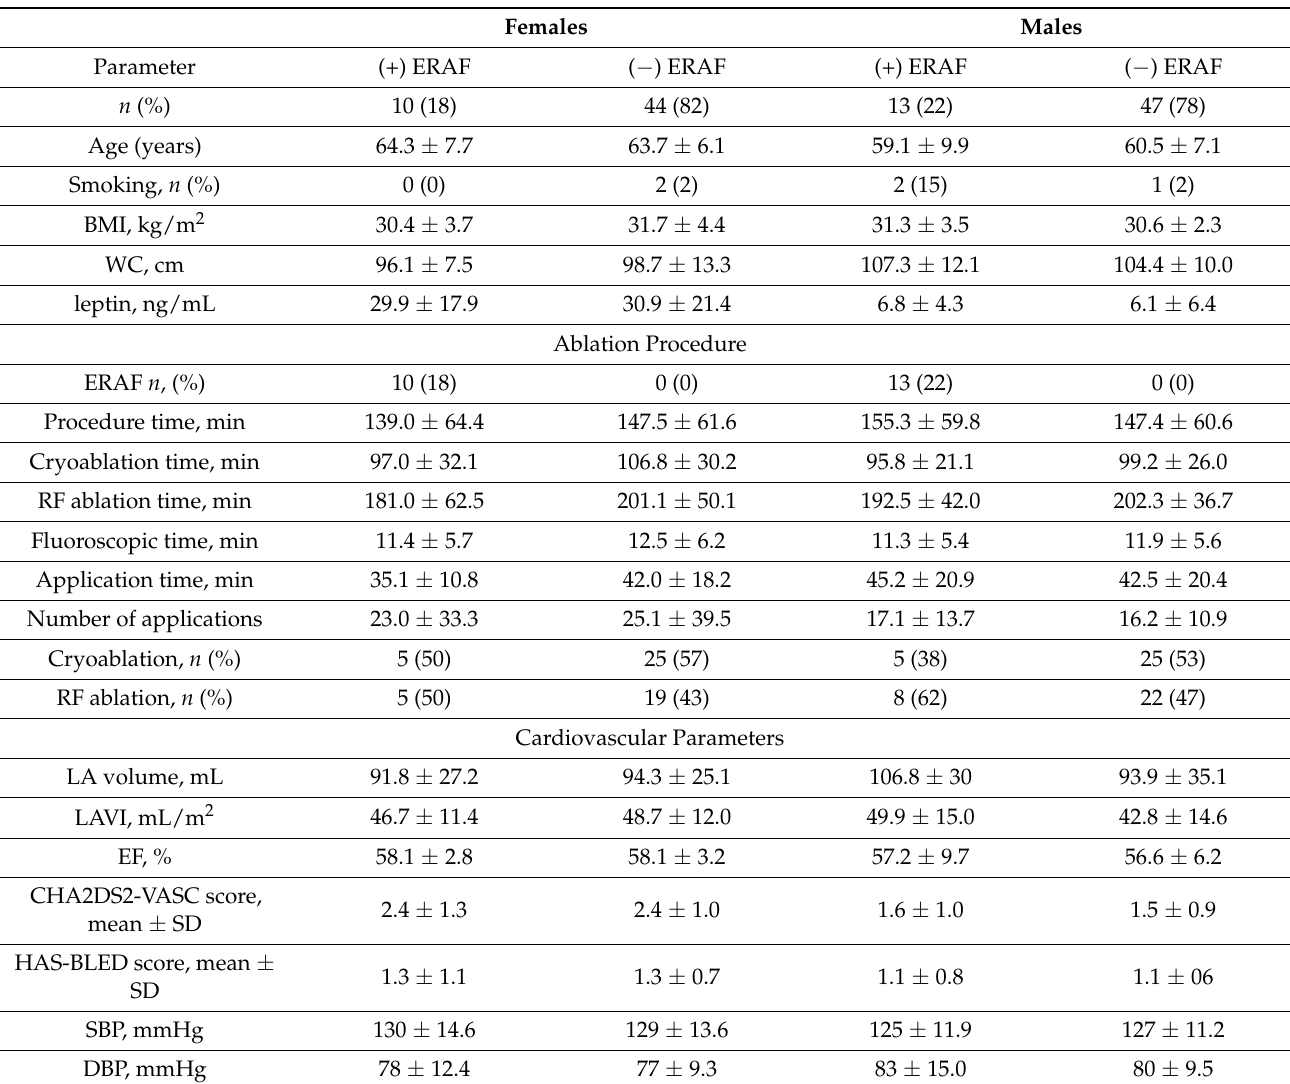
Table 3. Comparison of clinical and laboratory characteristics in obese females and obese males with and without ERAF following cryoballoon and RF